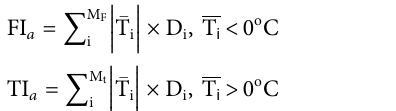
Frontiers in Earth Science |